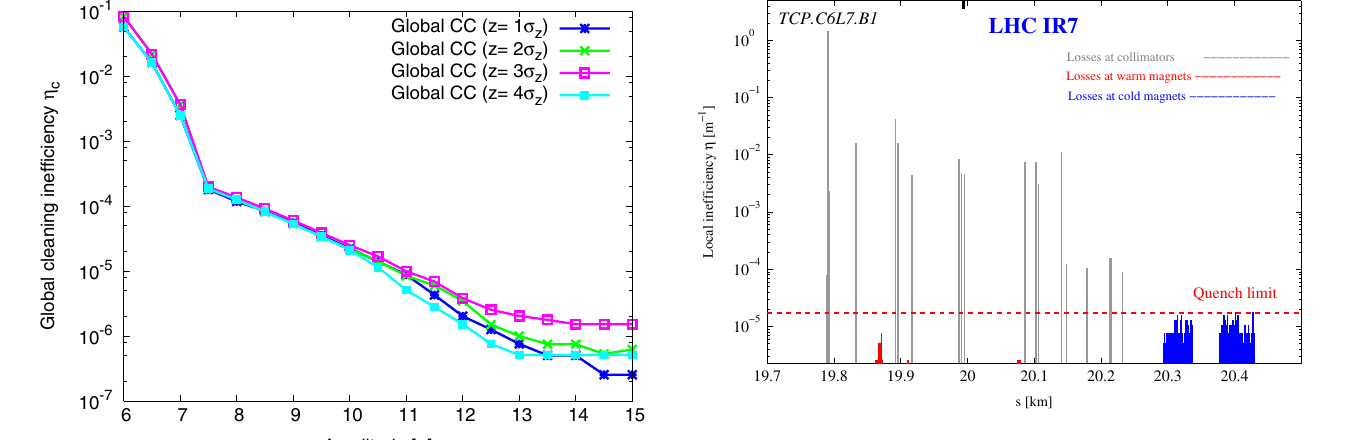
FIG. 15. (Color) Local cleaning inefficiency in LHC IR7, with- out global crab cavity (top energy, (cid:4) (cid:3) IP1 ; 5 ¼ 0 : 55 m ).